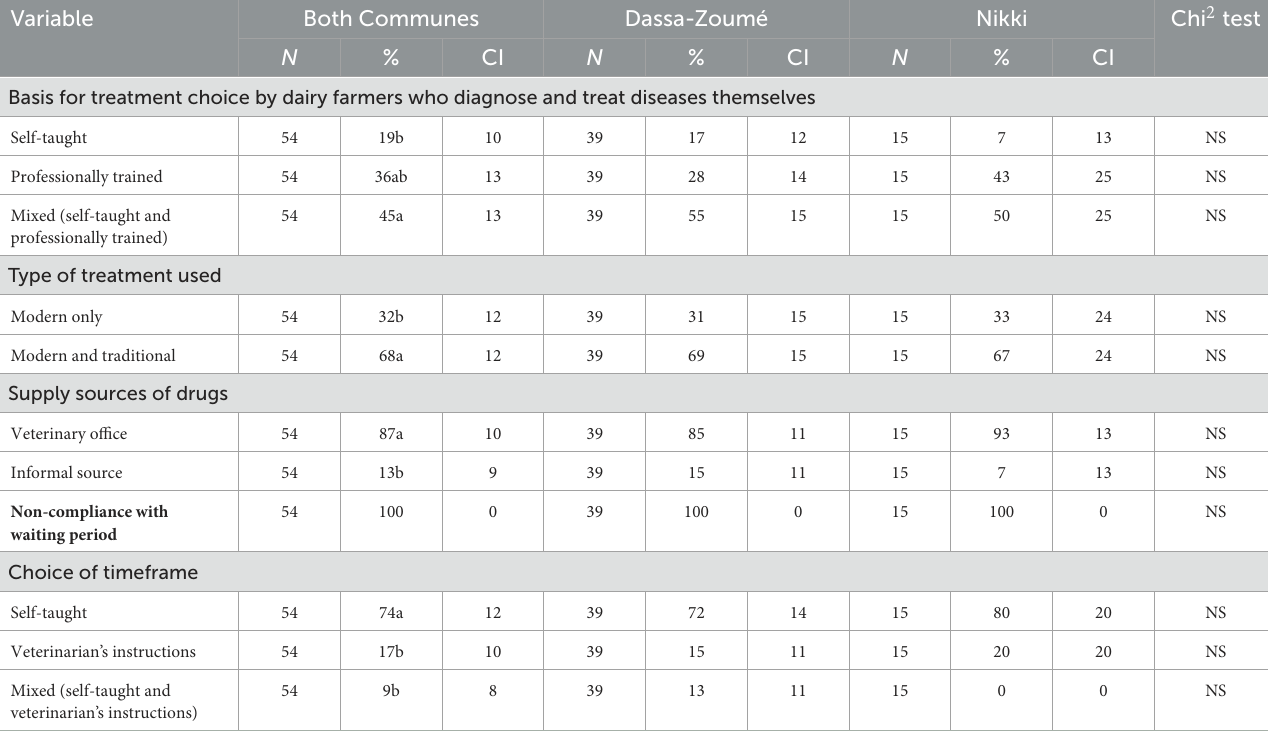
TABLE 3 Mode and type of treatment of listed livestock diseases and sources of drugs. Variable Both Communes Dassa-Zoumé Nikki Chi 2 test N % CI N %